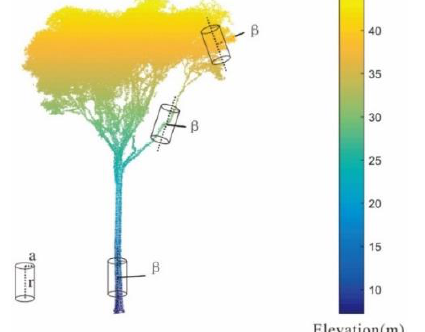
Figure 4. Local point density calculation using the cylinder with adaptive axis direction